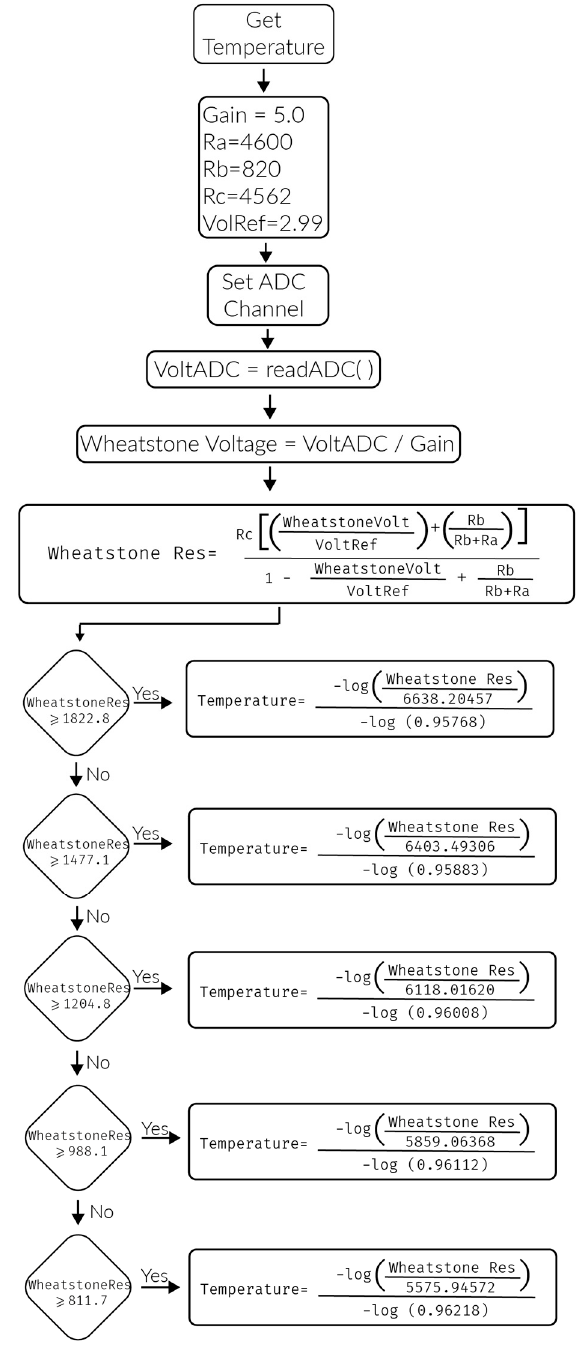
Figure 14. Temperature monitoring algorithm.